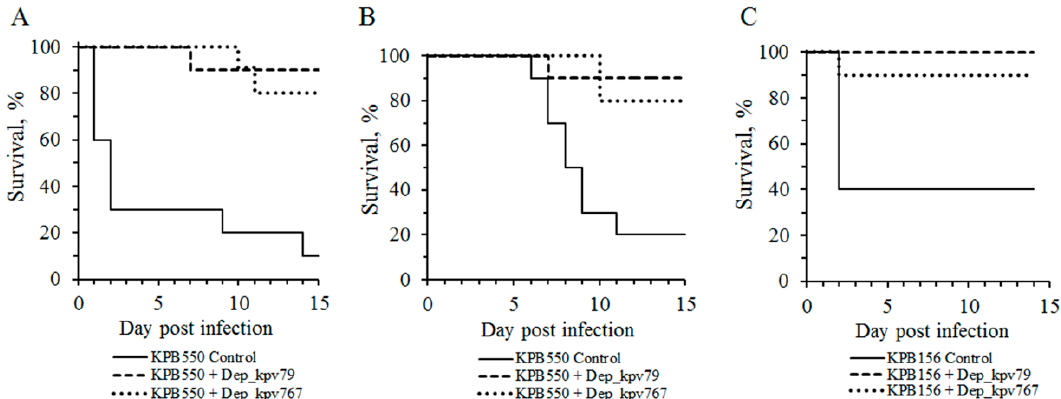
Figure 5. Protective effects of K57-specific depolymerases Dep_kpv79 and Dep_kpv767 of bacteriophages KpV79 and KpV767, respectively, in mice challenged with K. pneumoniae strains. Depolymerases (50 µ g per mouse) were administered intraperitoneally 30 min after infection. ( A ) Primary sepsis caused by K. pneumoniae KPB550 (intraperitoneal injection). ( B ) Thigh soft tissue infection caused by K. pneumoniae KPB550 (intramuscular injection). ( C ) Primary sepsis caused by K. pneumoniae KPB156 (intraperitoneal injection).